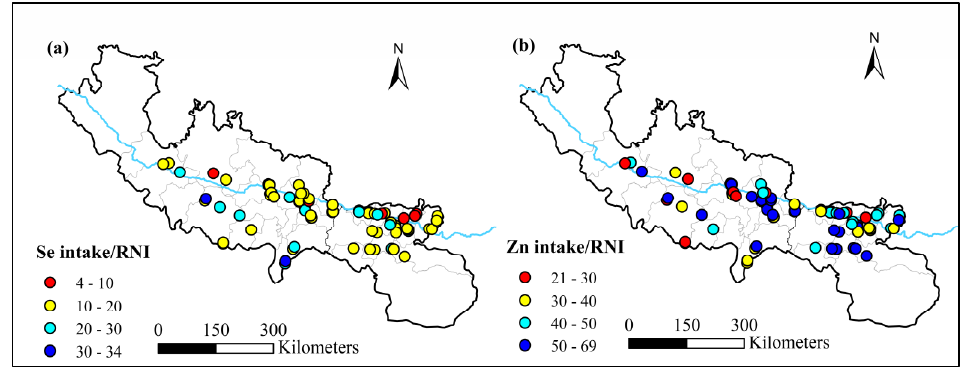
Figure 7. Contributions of Se and Zn intakes to RNIs (%). ( a ) Contributions of Se intake to RNI (%); ( b ) contribution of Zn intake to RNI (%).